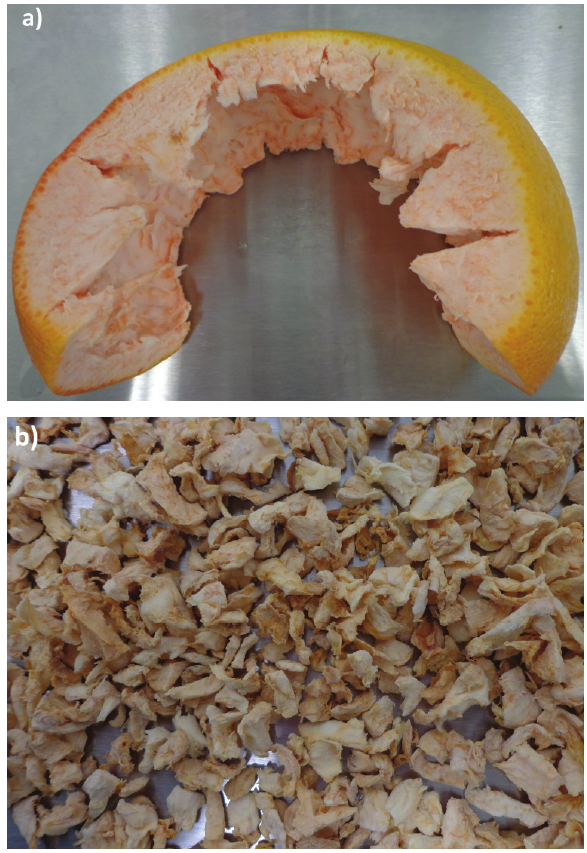
Fig. 1 – Raw grapefruit peel (a) and support material (be­ fore treatment) prepared from the albedo of grape­ fruit peel